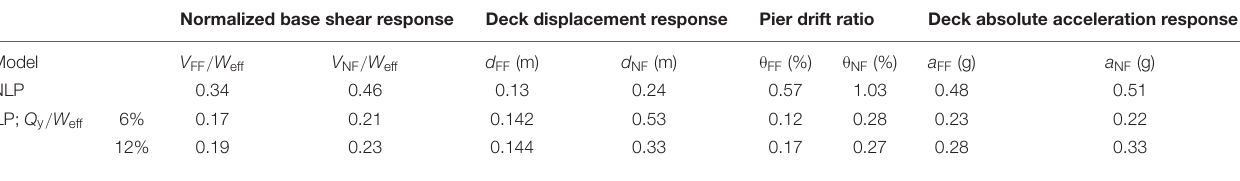
TABLE 2 | The mean value of the maximum resultant seismic responses under the NF and FF record pairs for the LC 1. Normalized base shear response Pier drift